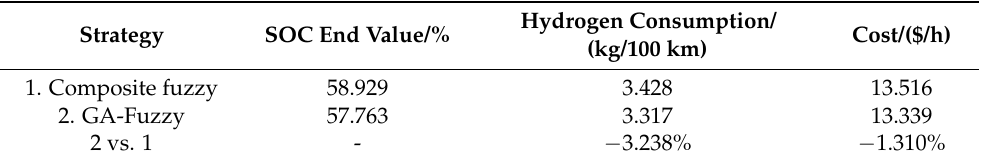
Table 5. Comparison of the economy and durability of the composite fuzzy control strategy before and after improvement.